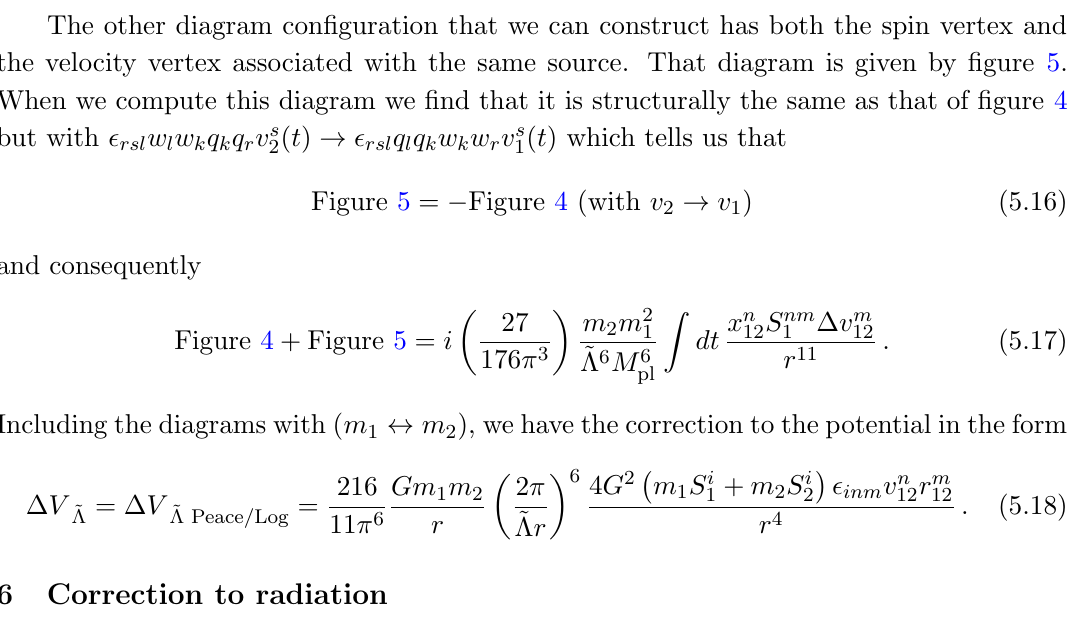
Figure 6 . The leading order radiative correction diagram from the represents the outgoing gravitational